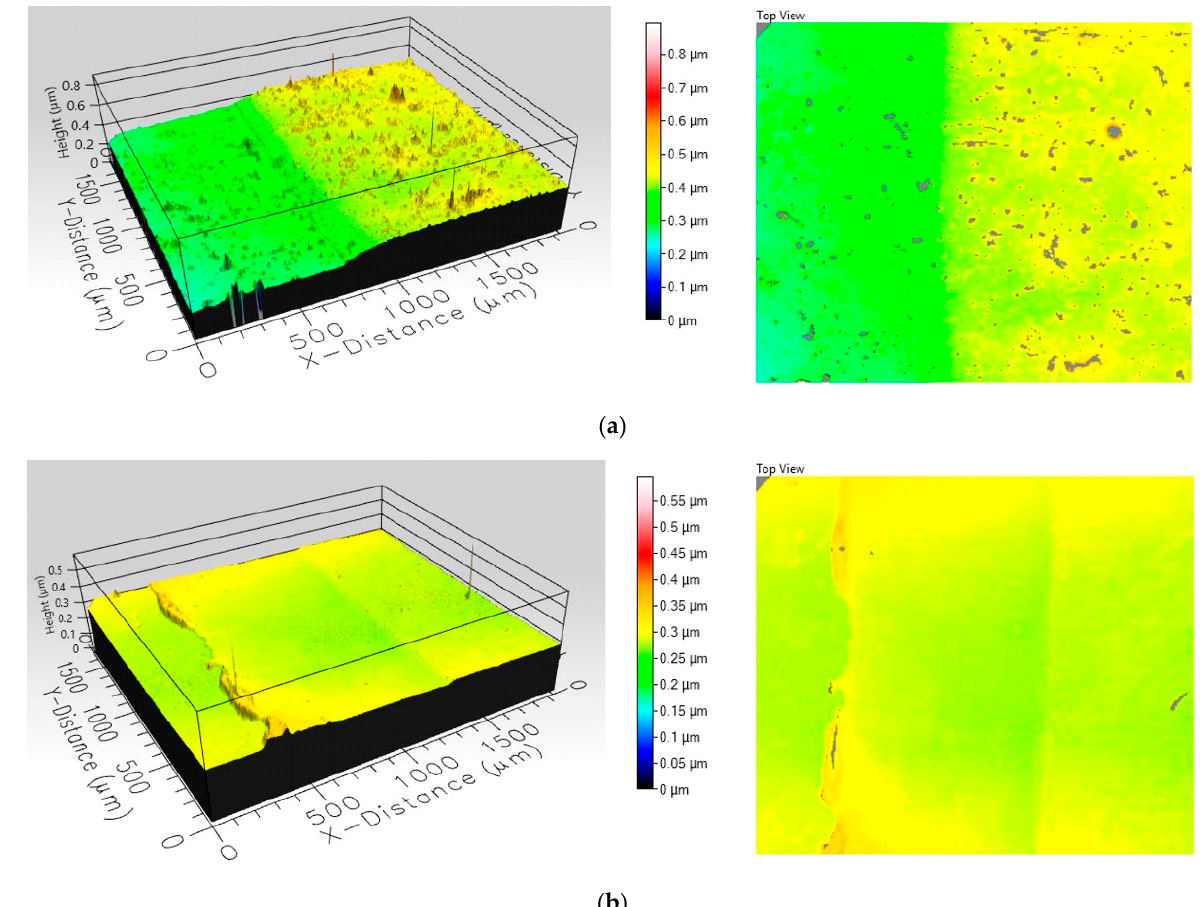
Figure 3. Surface profile of composite films deposited on glass slide substrates: ( a ) MgO—NaPAC16 and ( b ) TiO2—NaPAC16.